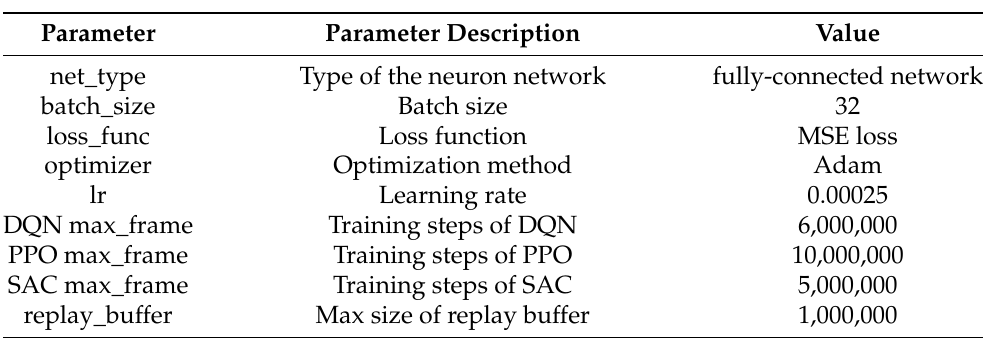
Table 3. Hyperparameters